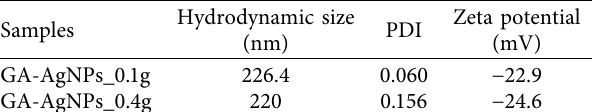
Figure 2: UV-vis analysis for GA-AgNPs. Table 1: DLS analysis of